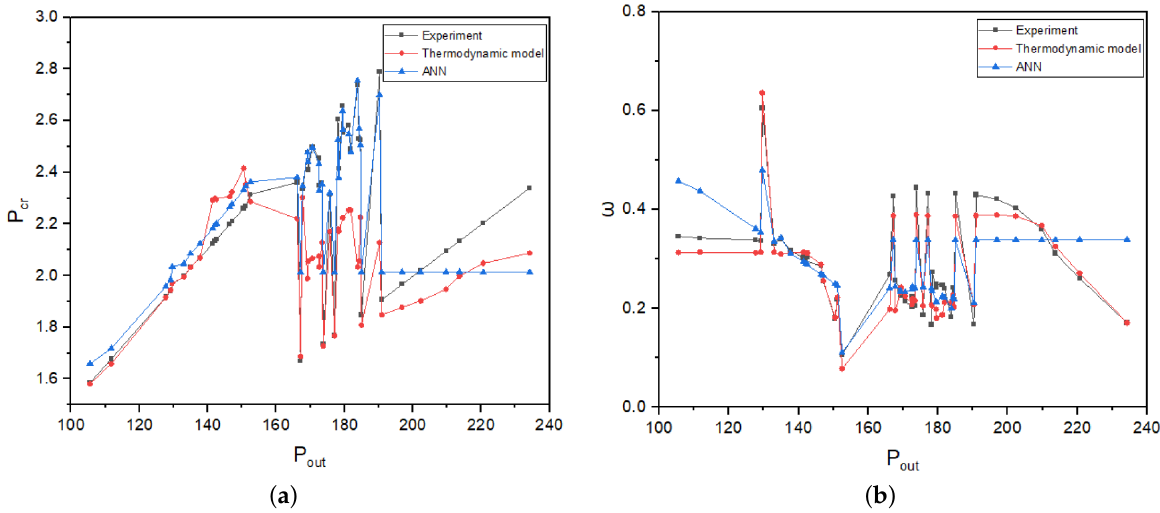
Figure 13. Comparison between the experimental data ( (cid:3) ), thermodynamic ( (cid:5) ) and ANN ( (cid:52) ) models in terms of ( a ) critical pressure P out and ( b ) entrainment ratio ω . Results obtained for a single-phase supersonic ejector working with R245fa and considered by Bencharif et al.